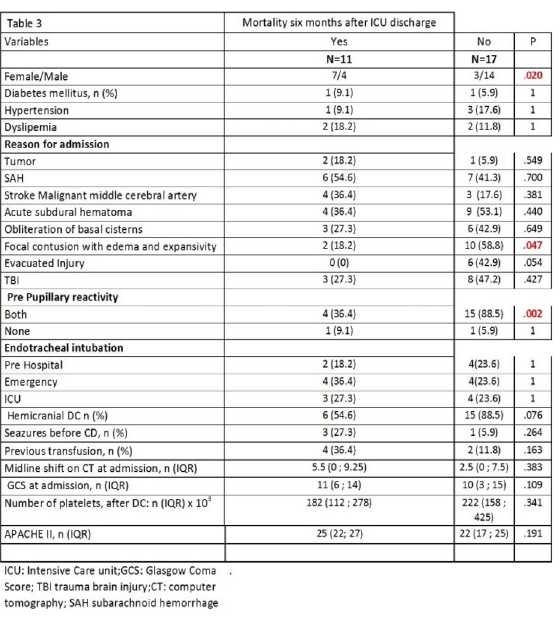
Table 3 (abstract 001016). See text for